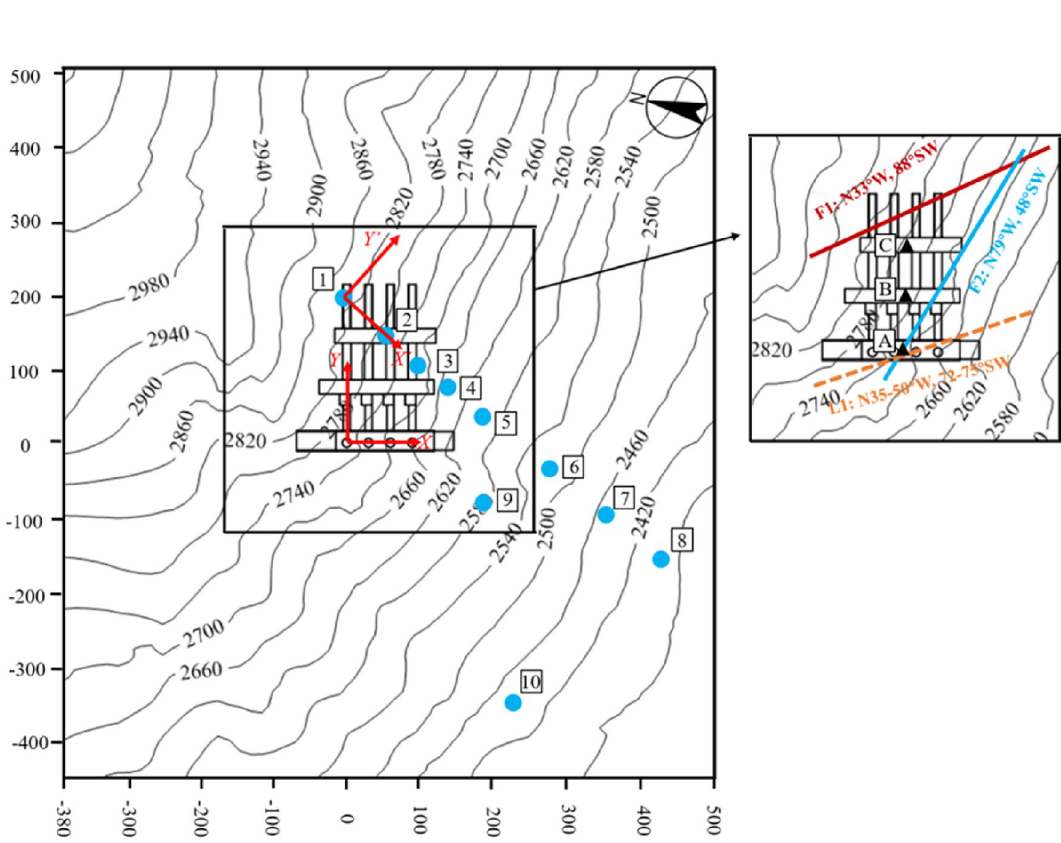
Figure 5. Schematic diagram of the underground powerhouses, faults, and measured